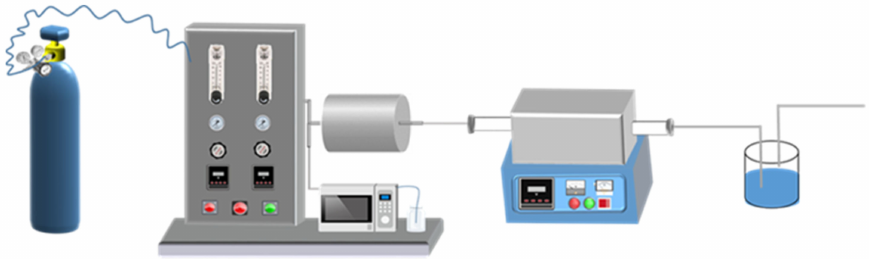
Figure 1. Schematic diagram of activation experimental